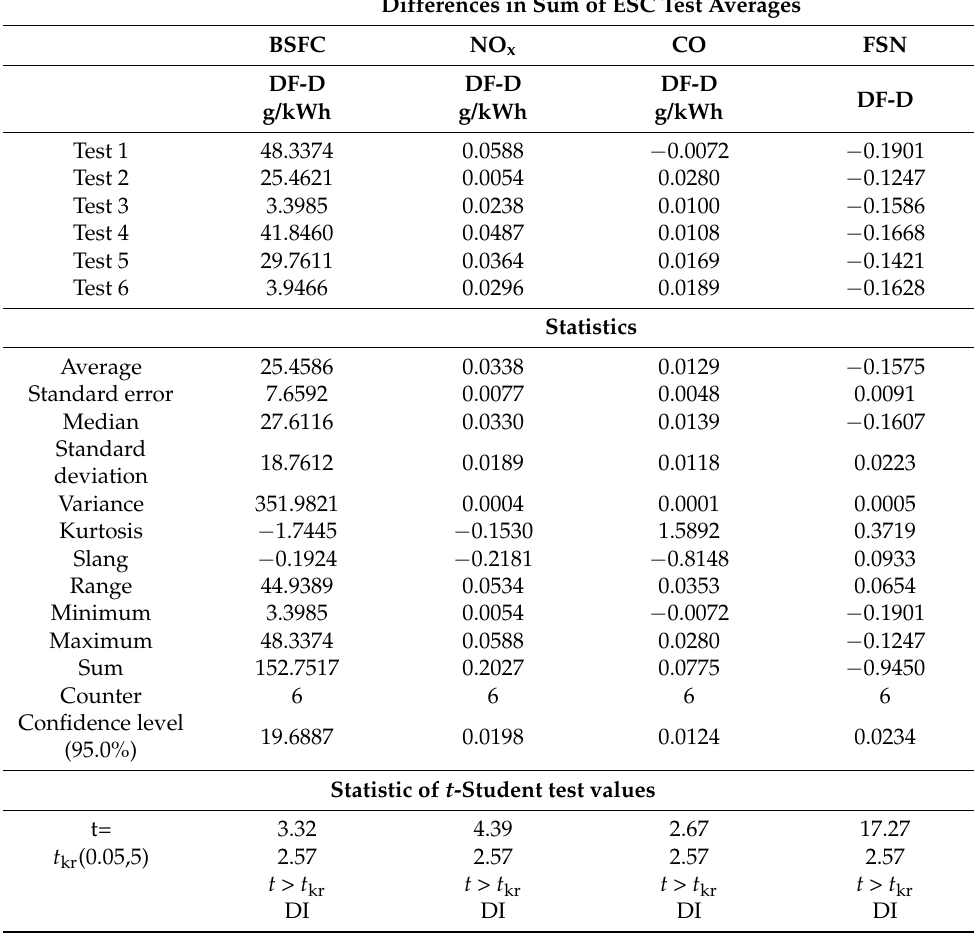
Table 3. Statistical evaluation of achieved results by feeding the engine with DF fuel vs. fed with conventional